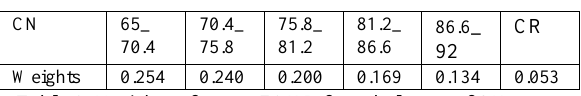
Table 9. Weights of group FAHP for subclasses of CN